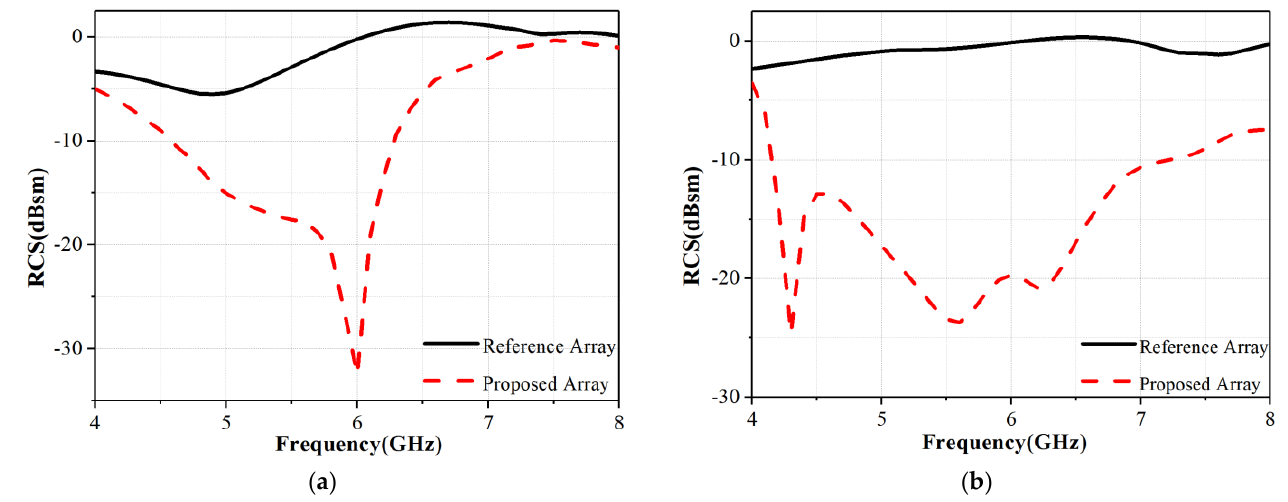
Figure 21. Monostatic RCS simulated results of the reference and proposed array antennas. ( a ) x − polarized; ( b ) y − polarized.